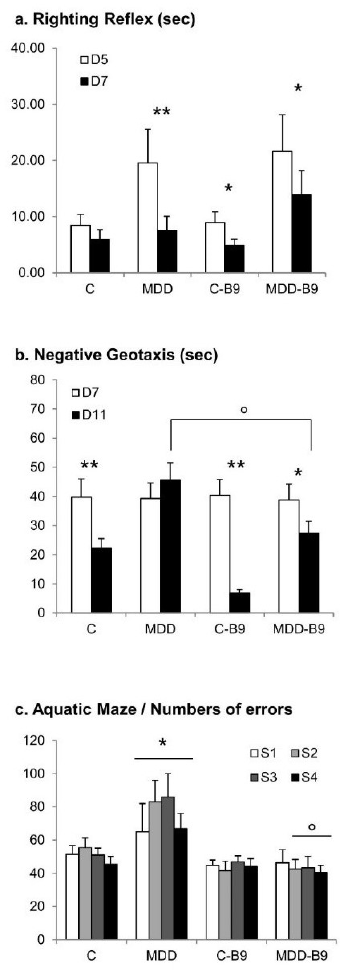
Figure 6. Effects of maternal methyl donor deficiency and folic acid supplementation on rat pup neurobehavioral development. ( a ) Sensorimotor righting reflex monitored at 5 and 7 days of age; ( b ) Negative geotaxis monitored daily between 7 and 11 days of age; ( c ) Learning and memory capacities as reflected by the number of errors in the water-maze from 21 to 24 days of age (sessions 1–4). Data are reported as mean ± SD (9 ≤ n ≤ 26). Statistically significant differences between control and MDD: * p < 0.05 and ** p < 0.01, between MDD and supplemented MDD: ° p < 0.05.